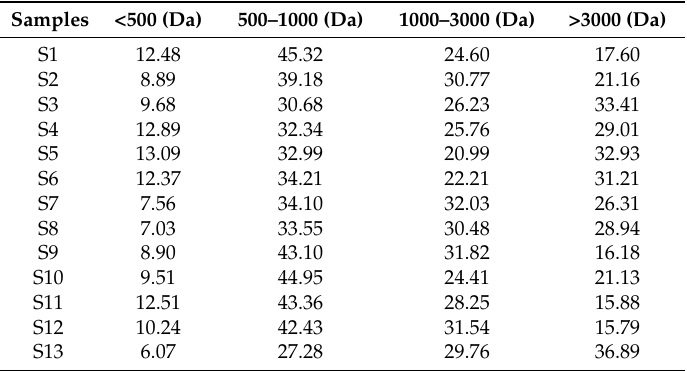
Table 5. Molecular weight distribution of collagen